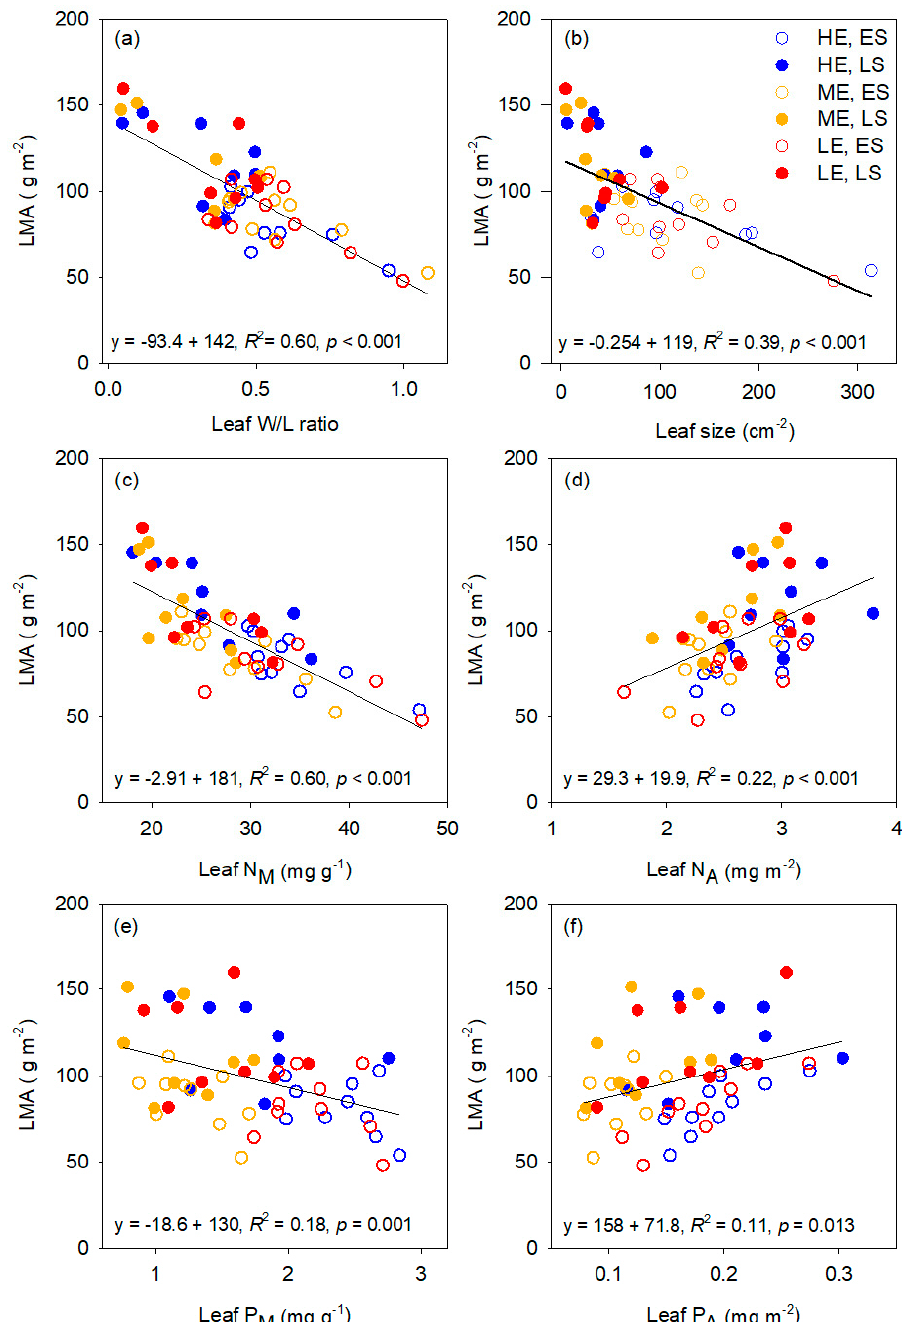
Figure 2. ( a – f ) Leaf mass per unit area (LMA, y axis) in relation to ( a ) leaf width-to-length ratio (leaf W/L ratio); ( b ) leaf size; ( c ) leaf nitrogen per unit mass (Leaf N M ); ( d ) leaf nitrogen per unit area (Leaf N A ); ( e ) leaf phosphorus per unit mass (Leaf P M ); ( f ) leaf phosphorus per unit area (Leaf P A ). Each data point represents species mean at each site. HE, High-elevation site (Sigira); ME, Medium elevation site (Rubona); LE, low elevation site (Makera); ES, early successional trees; LS, late successional trees. Lines, equation and R 2 represent the regression line for all sites and successional groups. p -value refers to the regression